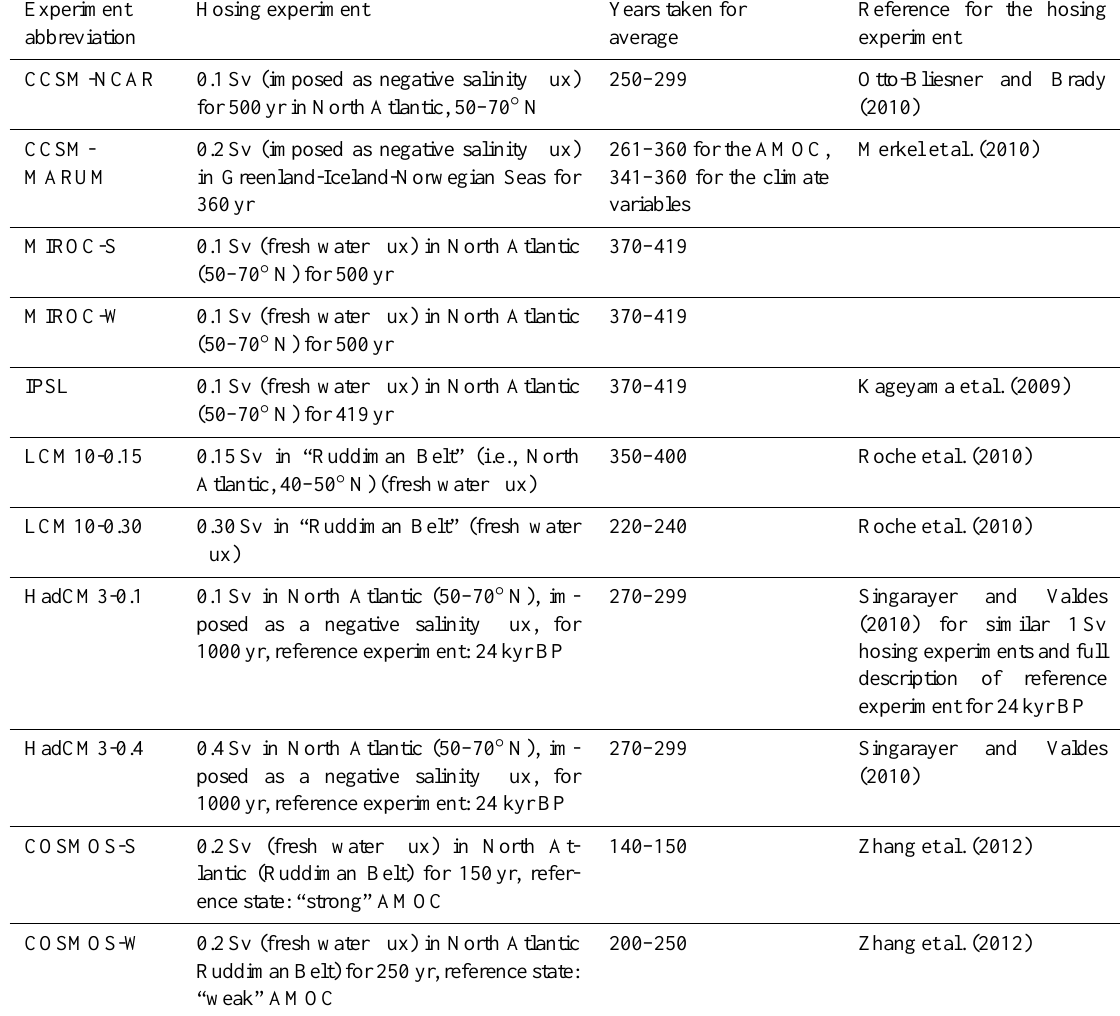
Table 2. Brief description of the experiments compared in this